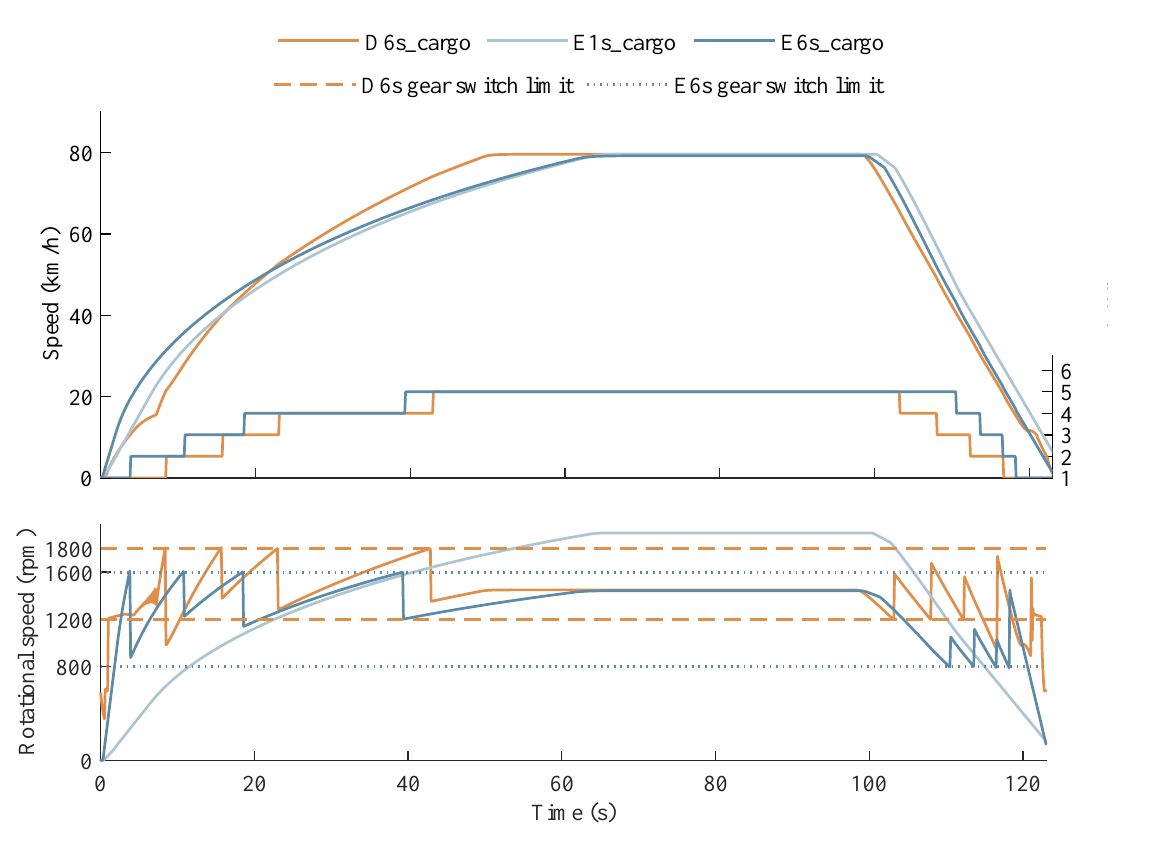
Figure 8. The acceleration cycle with gear changing ( upper graph ) and the corresponding rotational speed ( lower graph ) for the three vehicle types with the maximum mass. Note that E1s_cargo is the single-speed vehicle with a constant gear ratio, which is why its gear changes are missing.